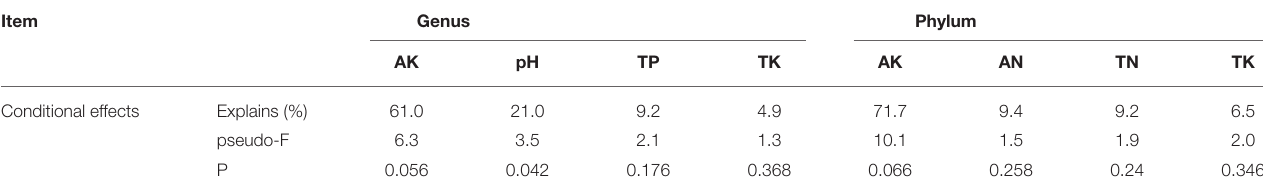
TABLE 5 | The RDA analysis of soil properties. Item